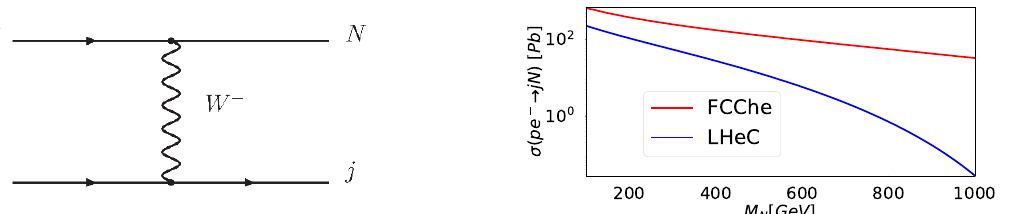
Figure 1 . Left: Feynman diagram representing the leading order production channel for heavy neutrinos in electron-proton scattering. Right: Cross section for heavy neutrino production in electron-proton collisions, divided by the active-sterile mixing paramter j (cid:18) e j 2